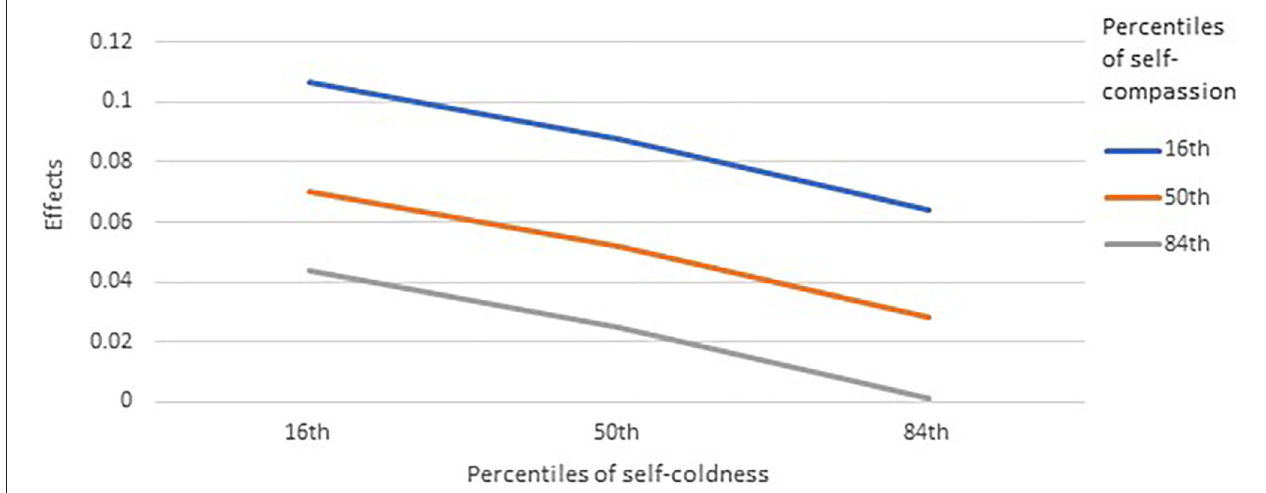
FIGURE 2 | Moderation roles of self-compassion and self-coldness on the effects between perceived threats and perceived benefits ( N = 761). Effects were unstandardized coefficients of the conditional effects of perceived threats on perceived